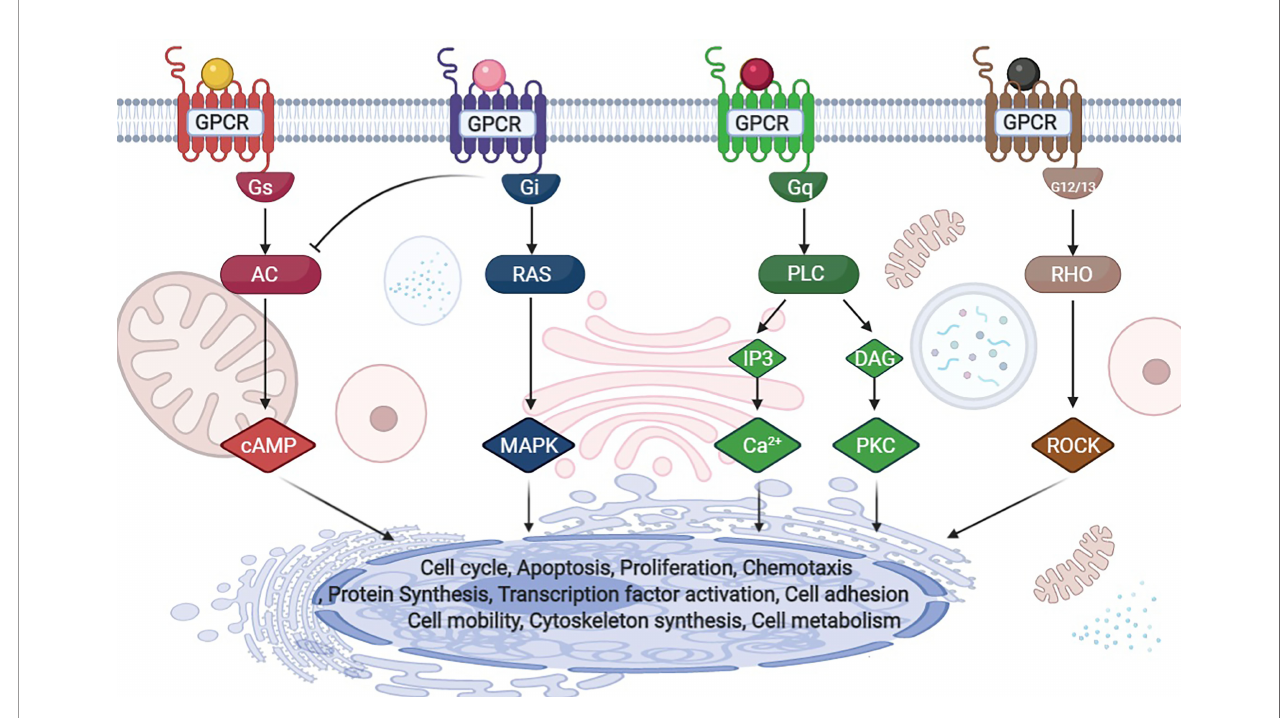
FIGURE 2 | G-protein classi fi cation and downstream